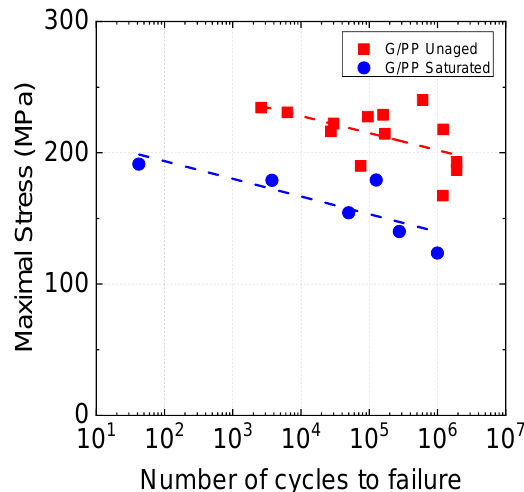
Fig. 7. S-N plots dry and after seawater saturation, glass/PP 0/90°.